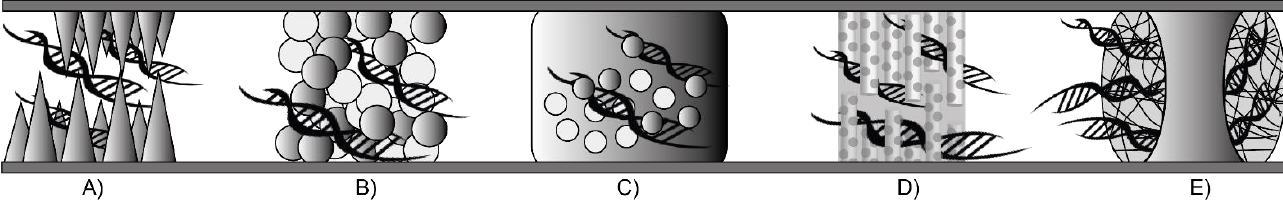
Figure 5. Examples of most common silica structures involved in adsorbing NA: ( A ) pyramidal micropillars [33]; ( B ) surfaces packed with silica microbeads [9,10,38,44,68,76]; ( C ) colloidal sol-gel solutions packed with silica microbeads [24,25,43]; ( D ) silica wafer monolith [31,39,42,65] or polymer monolith with silica microbeads [69,75]; ( E ) silica membrane filters [29,47,53,55,56,59,72].